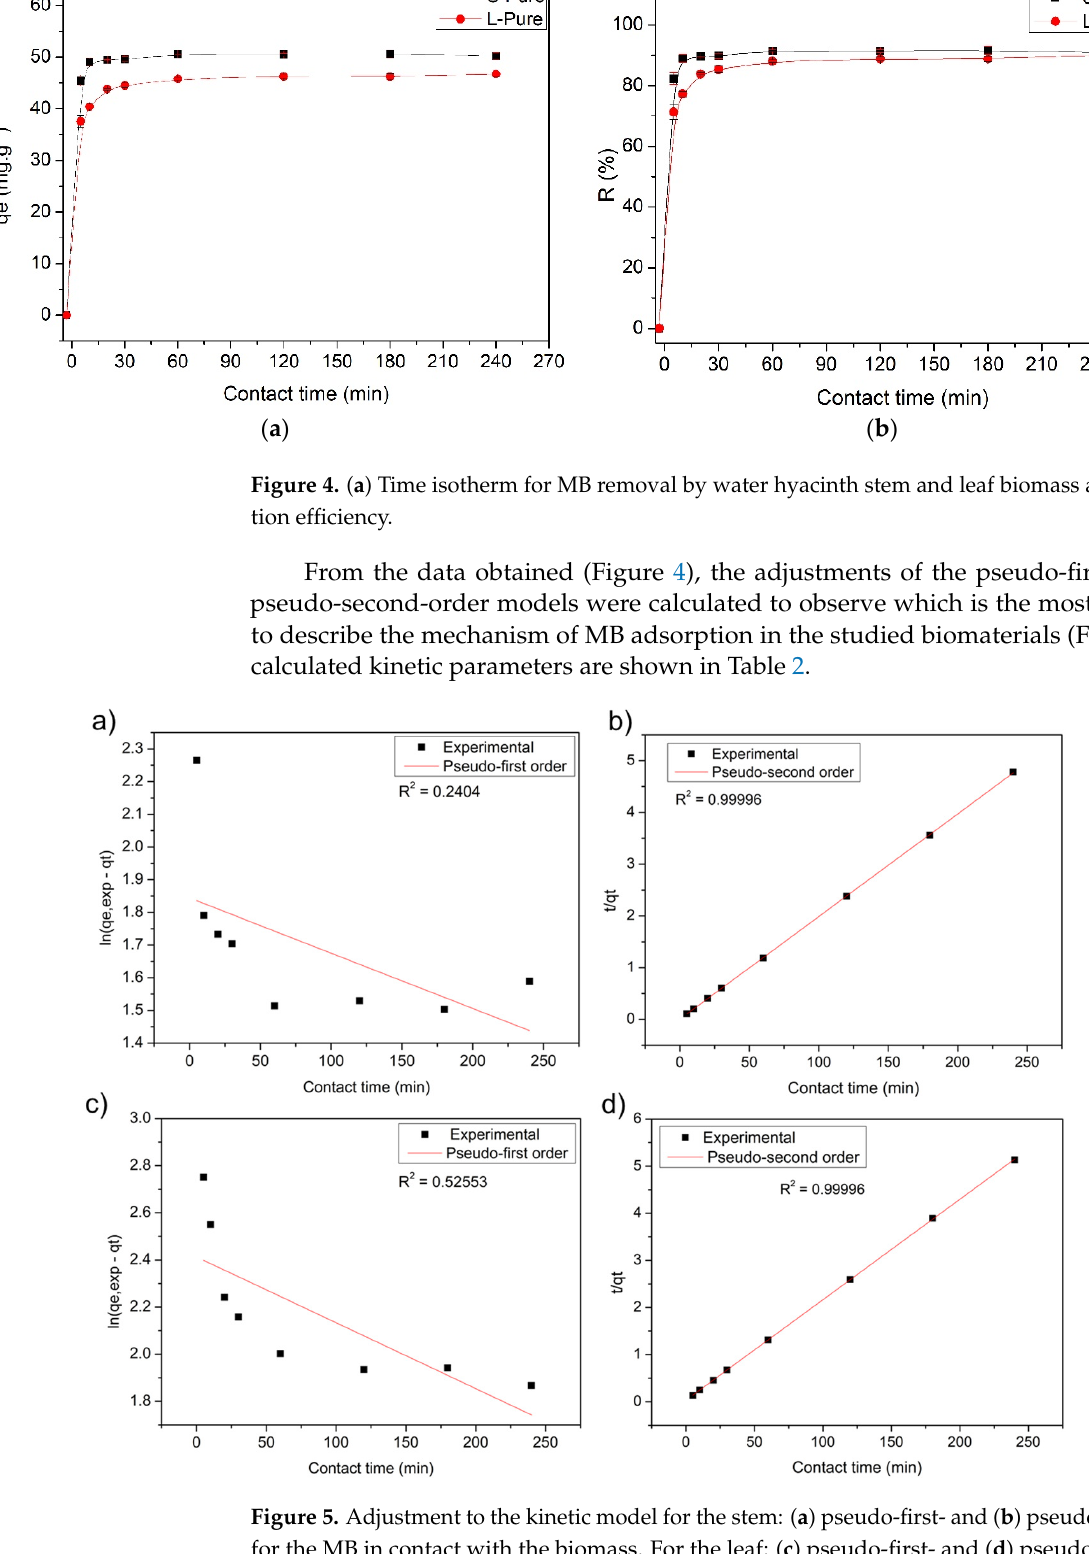
Table 2. Constant of the kinetic models of the stem and leaf of water hyacinth ( Eichhornia Crassipes ) in the adsorption of the methylene blue cationic dye.